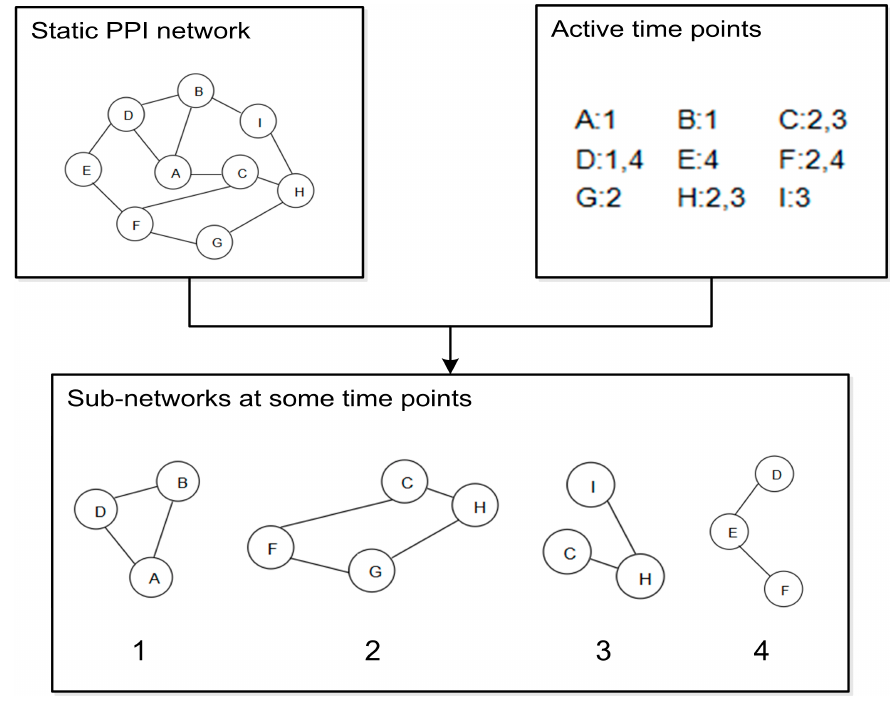
Figure 1. Dynamic protein-protein interaction (PPI) networks construction: (1) the subnet of time point 1; (2) the subnet of time point 2; (3) the subnet of time point 3; (4) the subnet of time point 4.